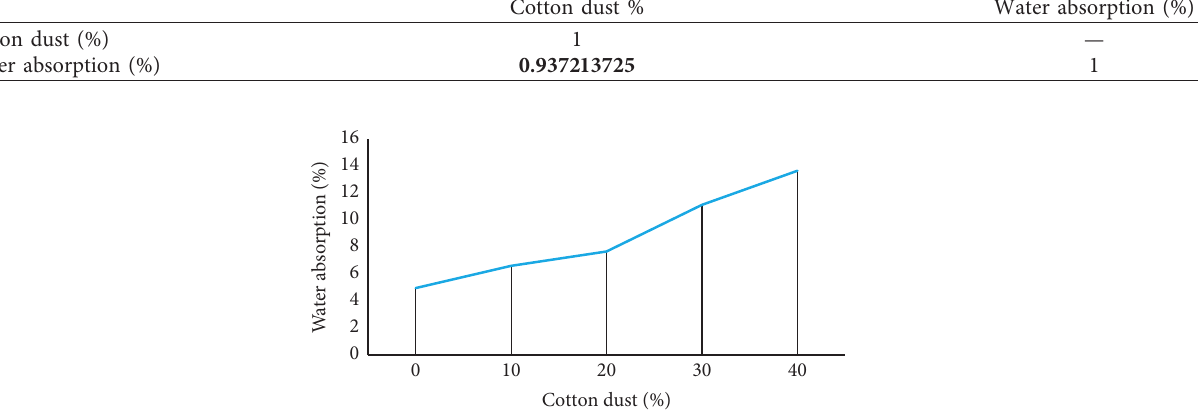
Figure 10: The effect of cotton dust on moisture absorption of the produced composite. Table 8: ANOVA (analysis of variance) of bricks for water absorption.